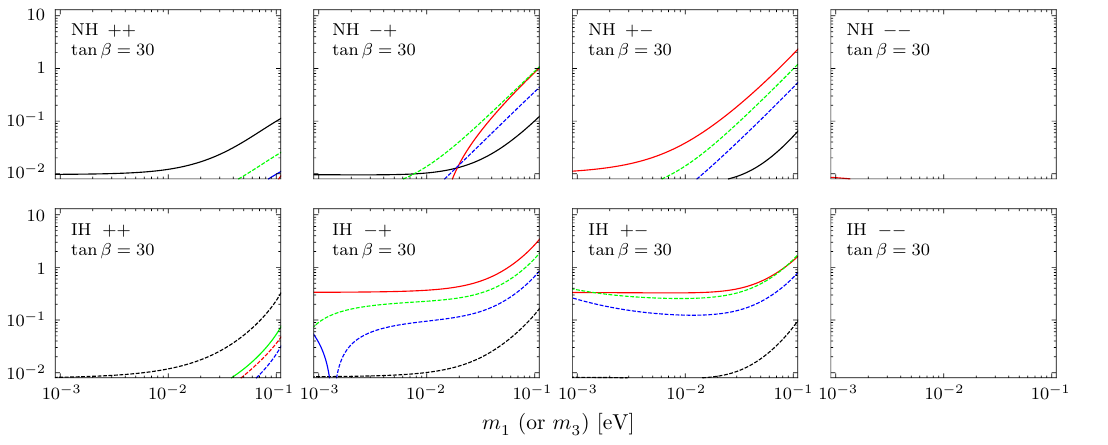
Figure 6 . The mixing-parameter deviations in the MSSM case with tan (cid:12) = 50 ((cid:1) (cid:18) in black, (cid:1) (cid:14) in red, (cid:1) (cid:26) in green and (cid:1) (cid:27) in blue) against the lightest neutrino mass m IH) case for various combinations of (cid:26) (0) and (cid:27) (0) with (cid:14) (0) = (cid:0) (cid:25)= 2. The signs ++ ; (cid:0) + ; + (cid:0) and (cid:0)(cid:0) respectively stand for [ (cid:26) (0) ; (cid:27) (0) ] = [0 ; 0] ; [ (cid:25)= 2 ; 0] ; [0 ; (cid:25)= 2] and [ (cid:25)= 2 ; (cid:25)= 2].